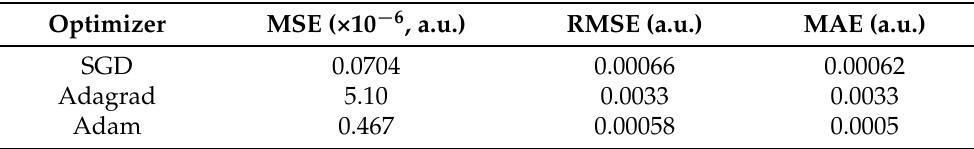
Table 3. Average of each model on evaluation metrics when predicting A ef f in the test dataset under different combinations of